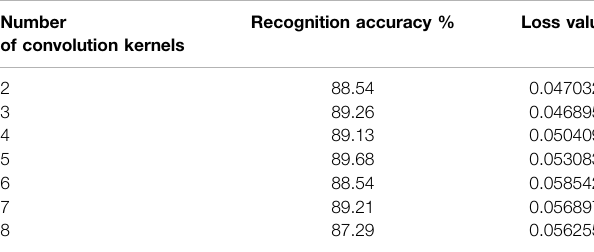
TABLE 2 | Recognition results under different number of convolution kernels.